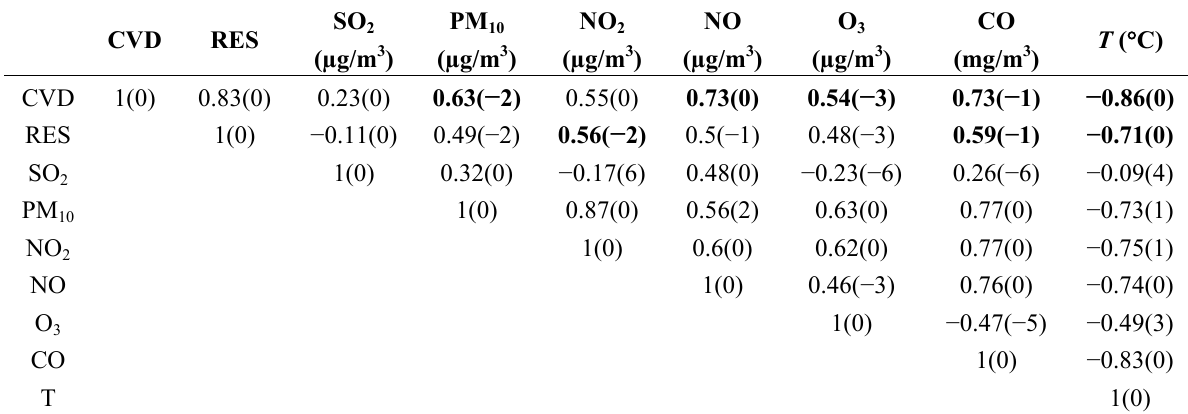
Table 2. Cross-correlation of monthly mortality, major pollutant concentrations and temperature with the associated time lag (in months) shown in parenthesis.